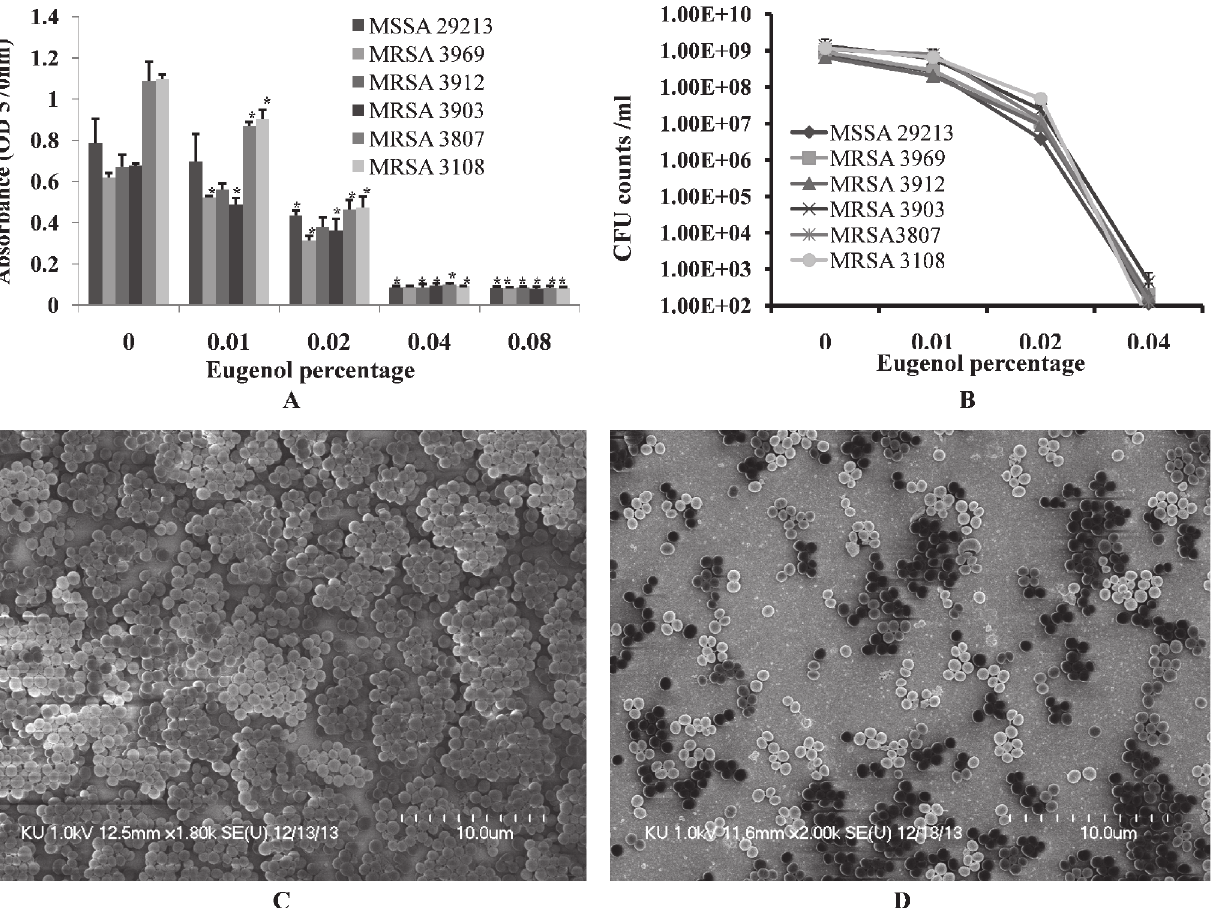
Fig 2. Inhibition of MRSA and MSSA biofilm growth in vitro with different concentrations of eugenol. (A) Decreased biofilm biomass detected using the microtiter plate assay. (B) Decreased cell viability within biofilms, detected by cfu counts. The error bars represent standard deviation from the mean value. (C) Representative SEM image of S . aureus (ATCC 29213) biofilm grown without eugenol supplement. (D) Representative SEM image of biofilms grown with 0.5×MIC eugenol. The SEM image scale bar corresponds to 10 μ m.